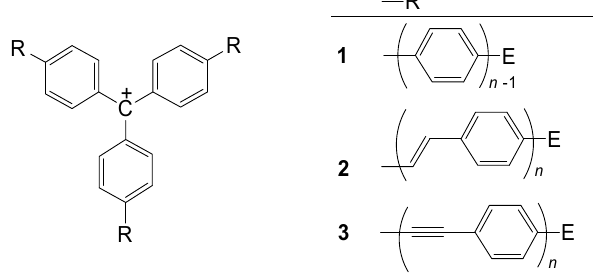
Figure 5. Triphenylmethylium structures with extended